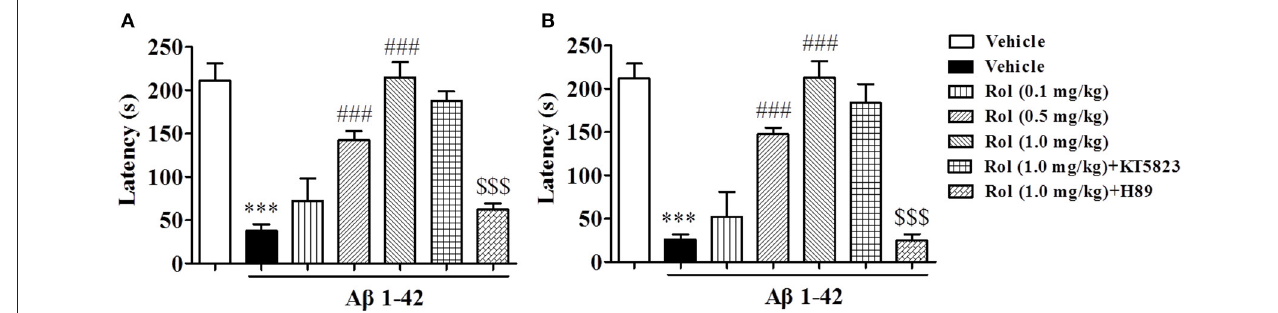
FIGURE 4 | The effects of rolipram on 3-h (A) and 24-h (B) memory retention in the step-down passive avoidance test in A β 42-treated mice. A β 42-induced decreases in 3-h and 24-h retention were reversed by chronic treatment with rolipram for 14 days Values shown are means ± SEM, n = 10; *** p < 0.001 vs. vehicle-treated control group. ### p < 0.001 vs. vehicle-treated A β group. $$$ p < 0.001 vs. rolipram (1.0mg/kg)-treated A β group.